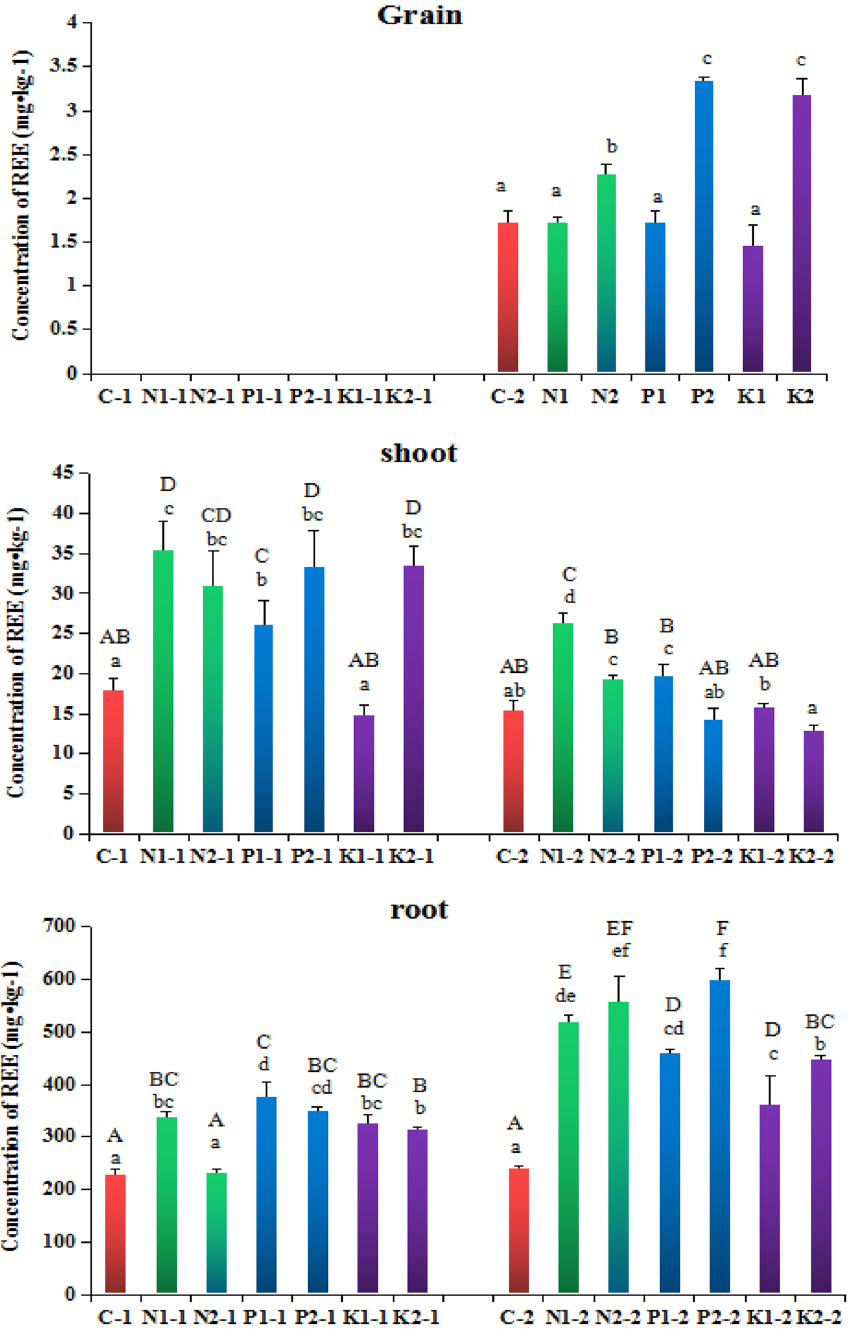
Figure 3. Effects of different rice straw returning methods on the content of REEs in rice roots, shoots and grains. Different letters indicate significant differences between potted rice in different soils (lowercase letters indicate the significant difference within the same stage and uppercase letters indicate the significant difference between the two stages), P <